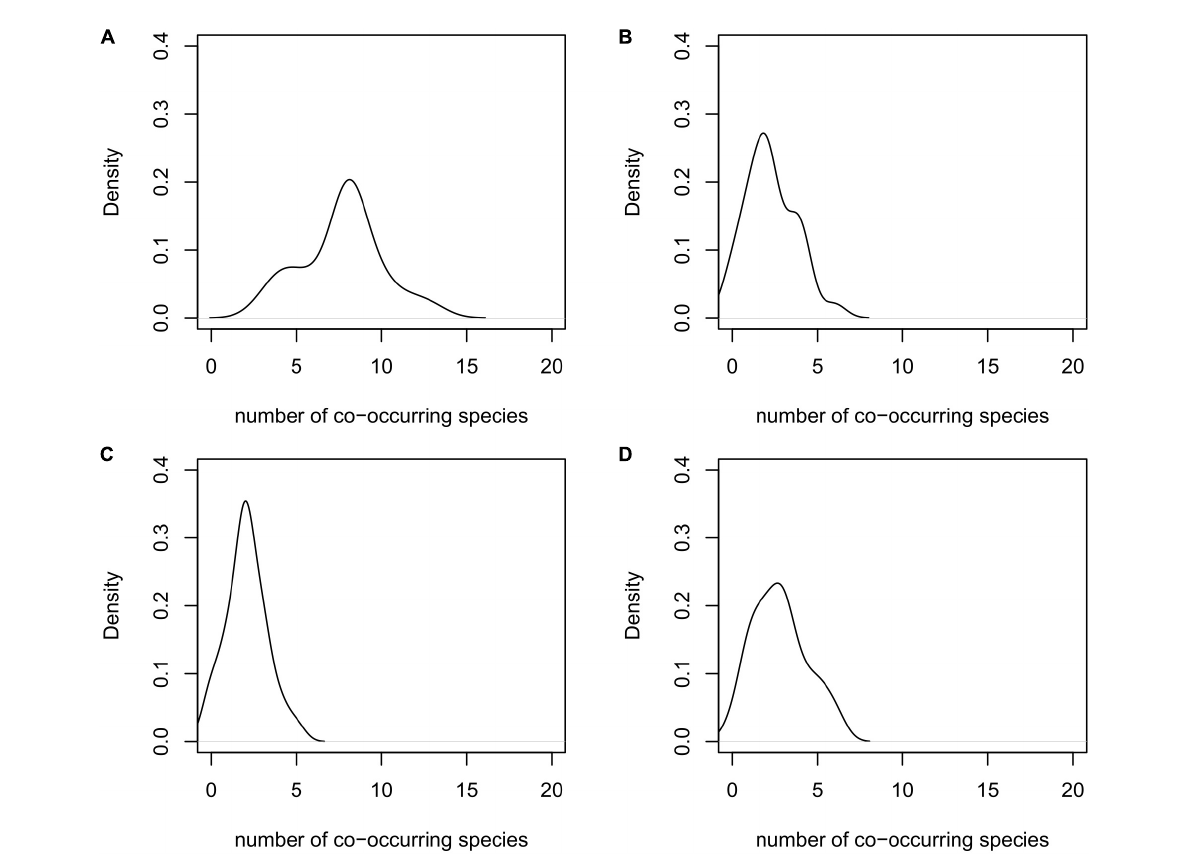
FIGURE6 Density plot of number of co-occurring species in GPNP (A) at present and under scenario (B) SSP2–4.5, (C) SSP3–7.0, and (D) SSP5–8.5 in